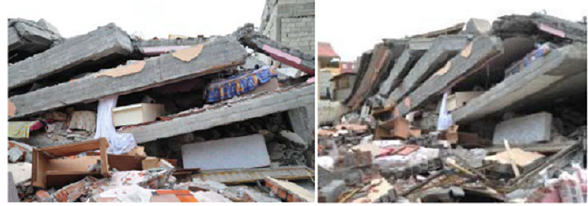
Figure 19. Full collapse of a building as a result of plastic hinges in the bottom and top zones of columns in a reinforced concrete structure in Van–Ercis (Onen et al.,